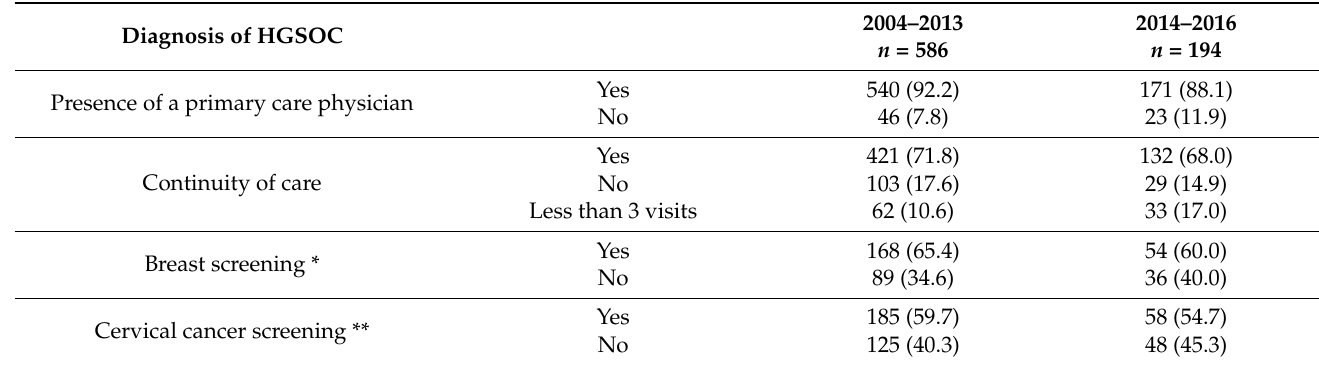
Table 2. Health care utilization by HGSOC patients in Manitoba, 2004–2016.